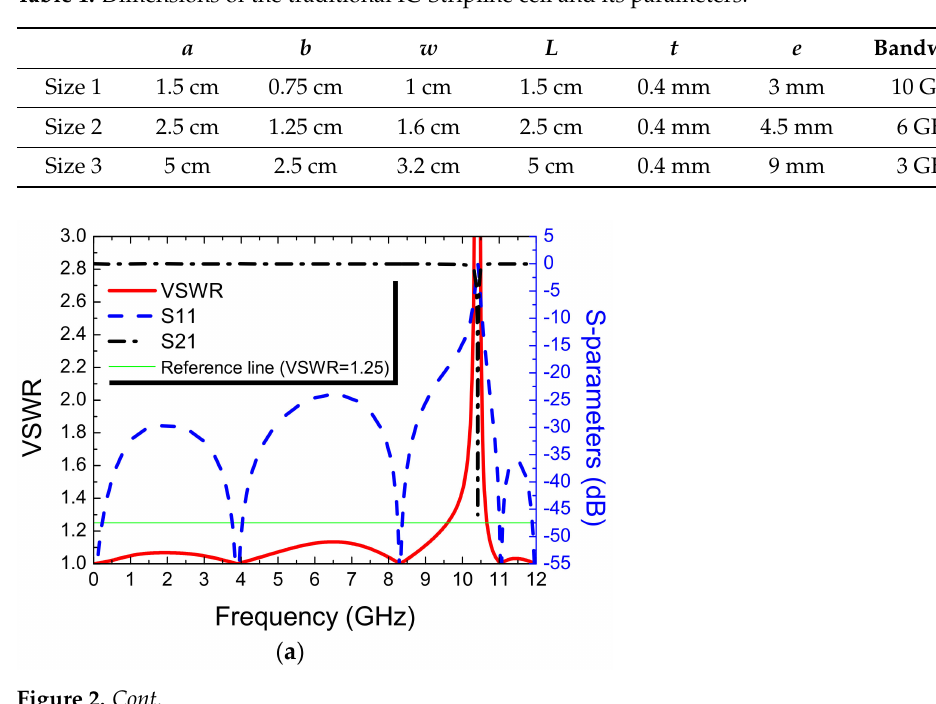
Figure 1. IC-Stripline cell. ( a ) Three views. ( b ) The picture of traditional closed version IC-Stripline cell. The cover of the cell is removed. Table 1. Dimensions of the traditional IC-Stripline cell and its parameters.